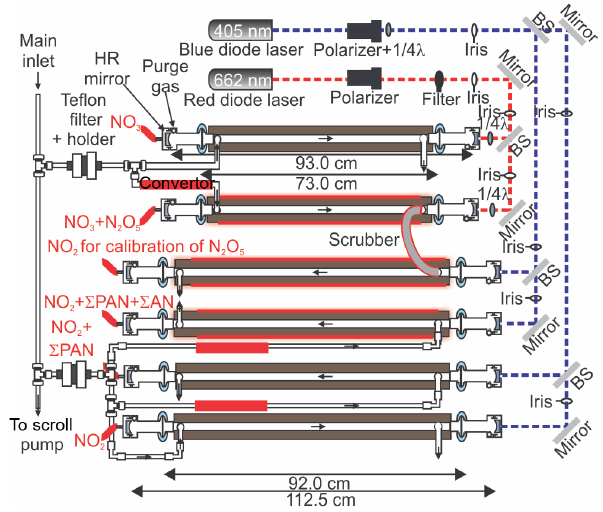
Figure 2. Optical layout of the cavity ring-down spectrometer. 1/4 λ refers to quarter-wave plate. BS is the beam splitter. HR mirror refers to the high-reflectivity mirror. Drawing is not to